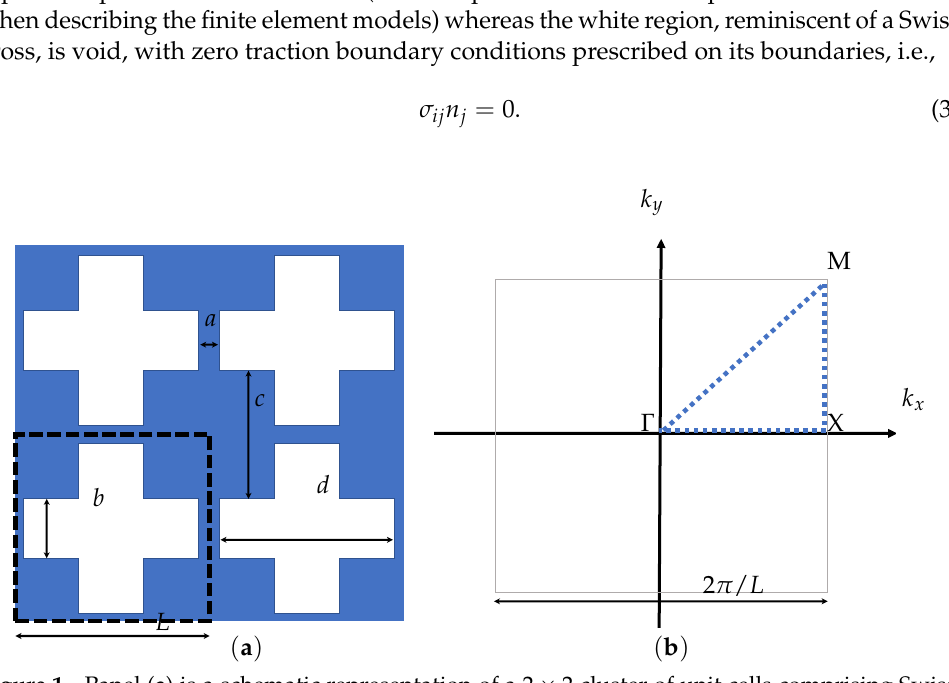
Figure 1. Panel ( a ) is a schematic representation of a 2 × 2 cluster of unit cells comprising Swiss- cross holes. The black dashed square of side-length L encloses an individual unit cell. Panel ( b ) shows the first Brillouin zone of the unit cell in panel ( a ), where the dashed blue lines indicate its irreducible